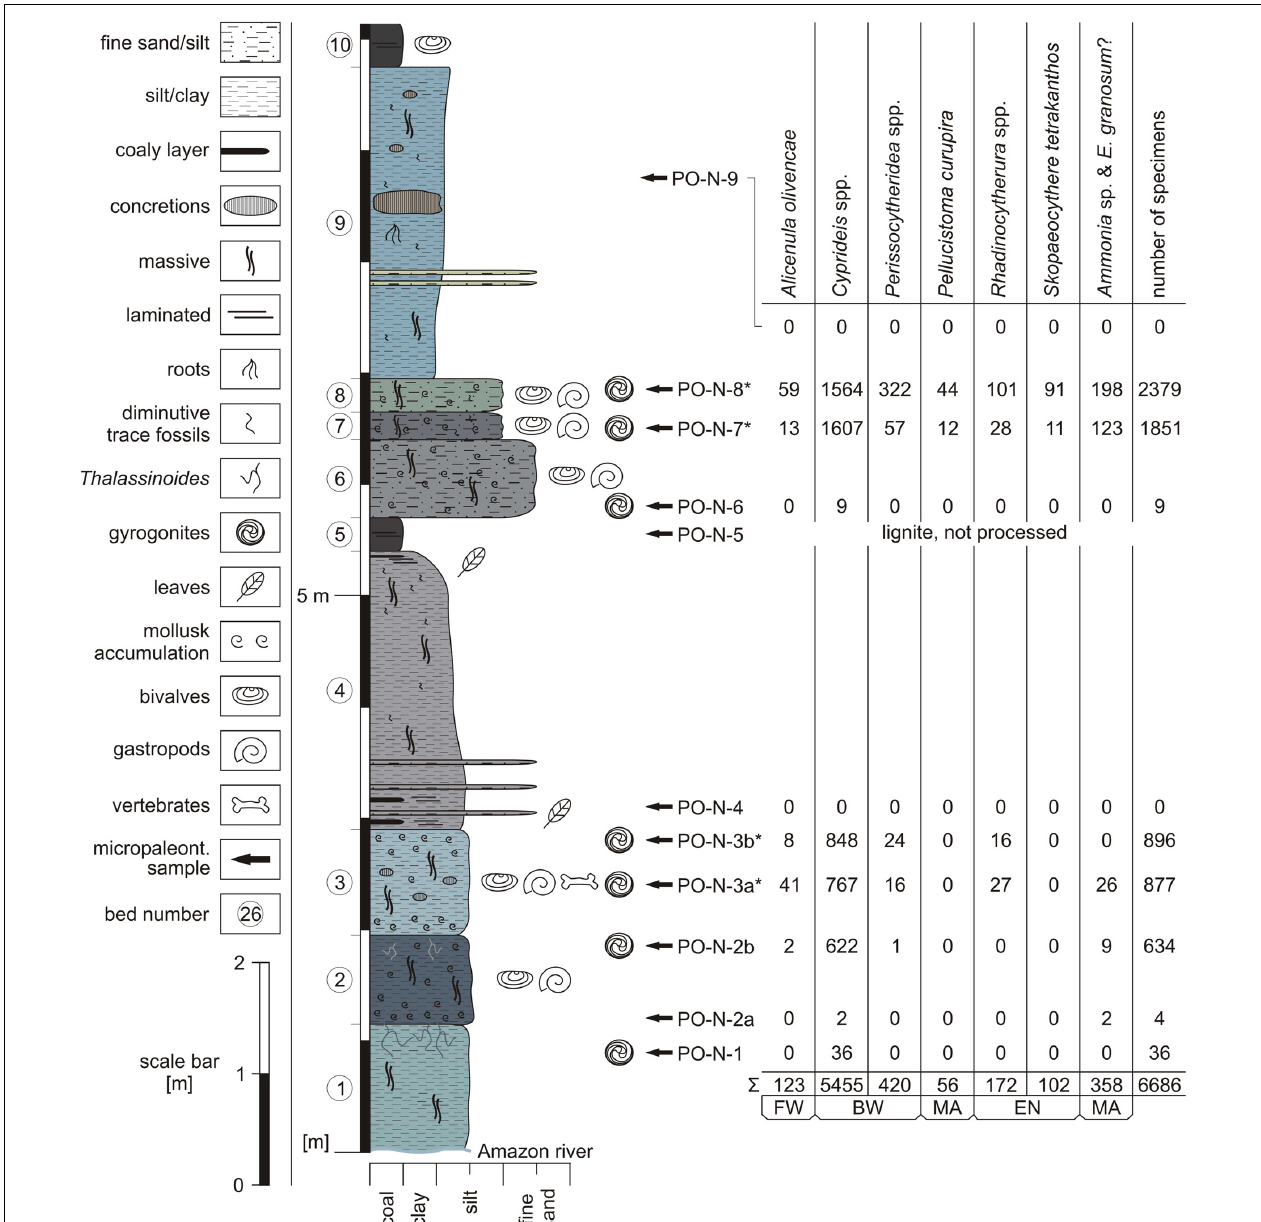
FIGURE 2 | Lithological section of the outcrop north of Porvenir and fossil content (FW = freshwater, BW = brackish water, MA = marine, EN = endemic taxa; *only 1/4 of available specimens determined and counted; modified from Gross and Piller, 2019).